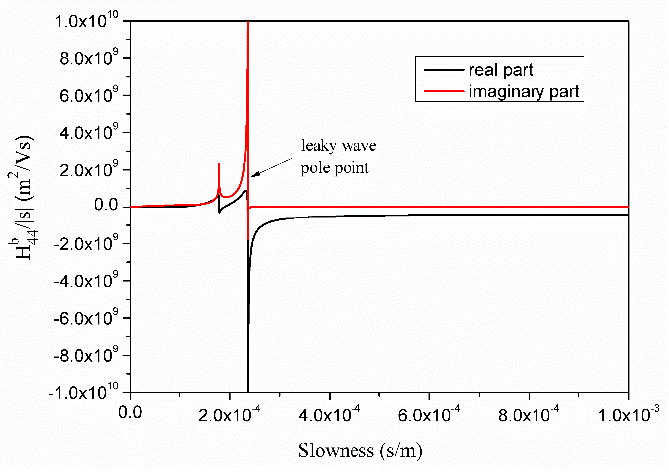
b ( s ) 44 when s ∈ [0, 1 × 10 − 3 | s |